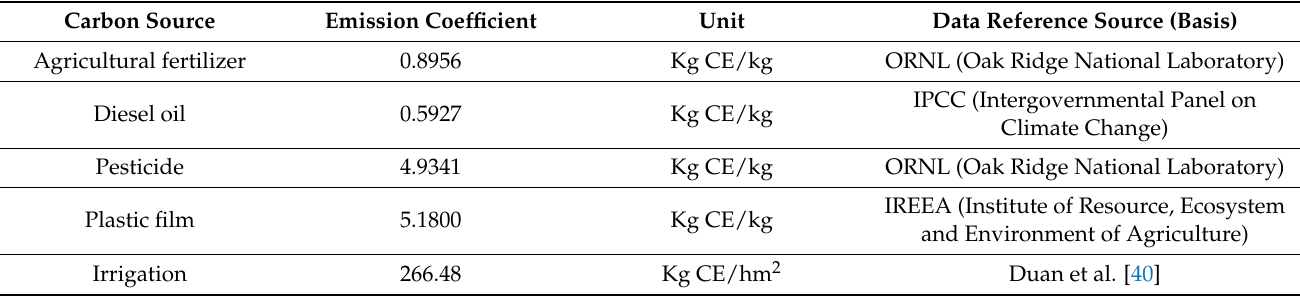
Table 1. Carbon emission coefficients for each factor of production.